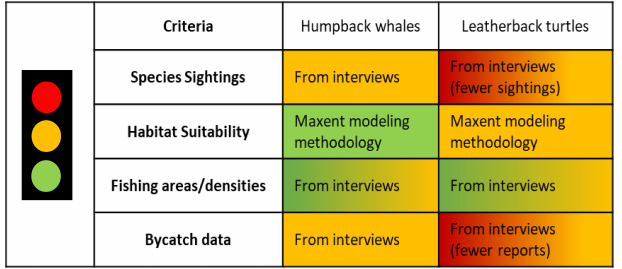
Coloration signals data quality and uncertainty in final outputs.